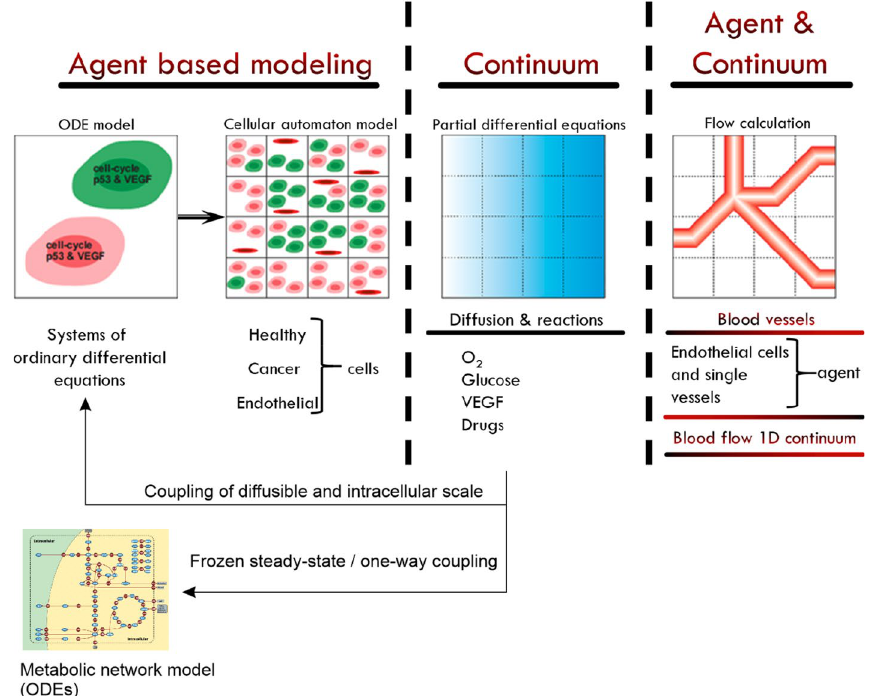
Figure 1. Multiscale model overview 57 . Metabolic network model reprinted from 53 under a CC BY license, with permission from BMC Systems Biology, original copyright